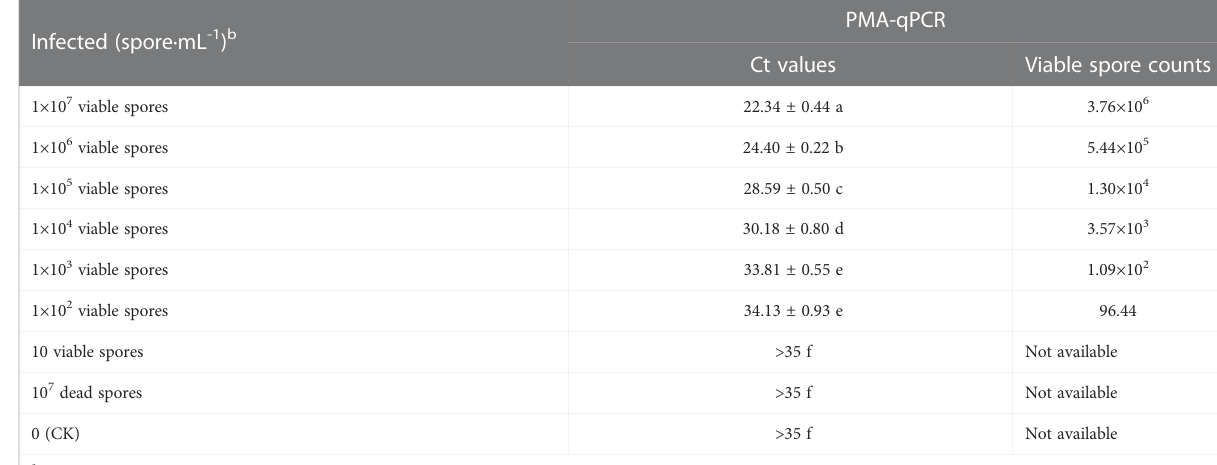
TABLE 2 Determination of viable cells in soil samples arti fi cially infected with C. cassiicola by different methods a .